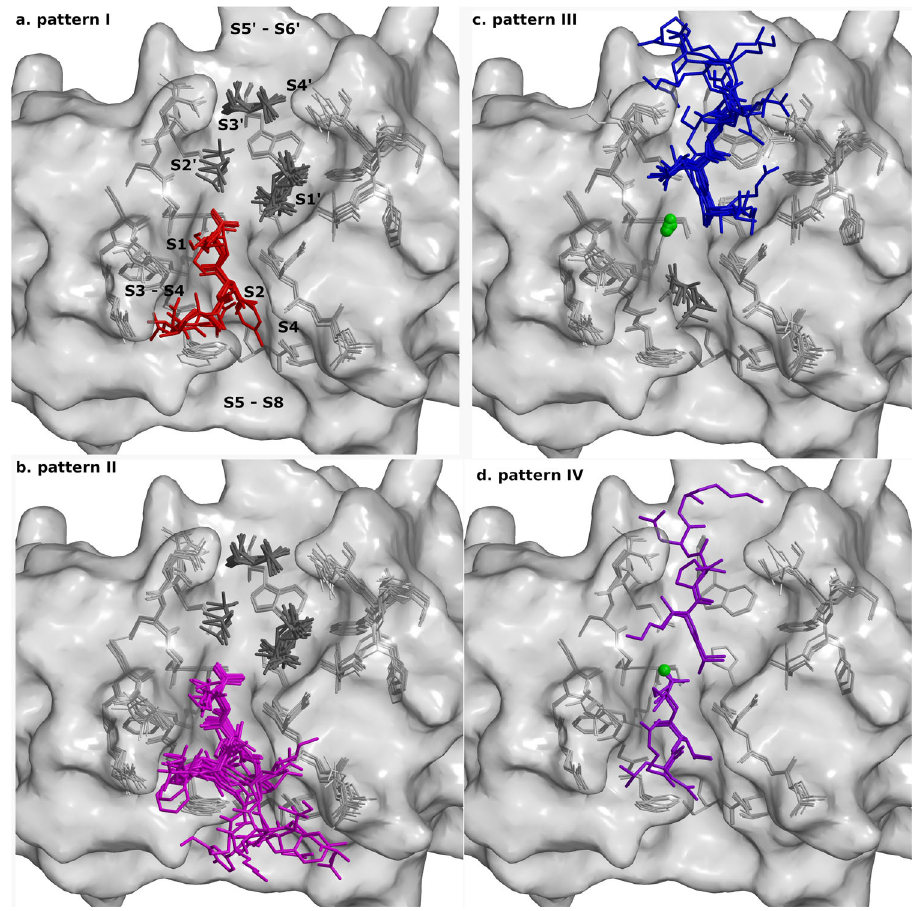
Fig. 5 Binding geometry of peptides. Crystal structures of all complexes of cathepsin V were superimposed. Bound peptides are shown on the background of cathepsin V active site residues shown as gray sticks and the surface is shown in semi-transparent gray. The bound peptides are shown as stick models colored according to the patterns ( a ) I (red), ( b ) II (purple), ( c ) III (blue) and ( d ) IV (violet). Chlorine ions are shown as green balls and MPD molecules as dark gray sticks. The fi gures were generated with MAIN 59 and rendered with RASTER 3D 66